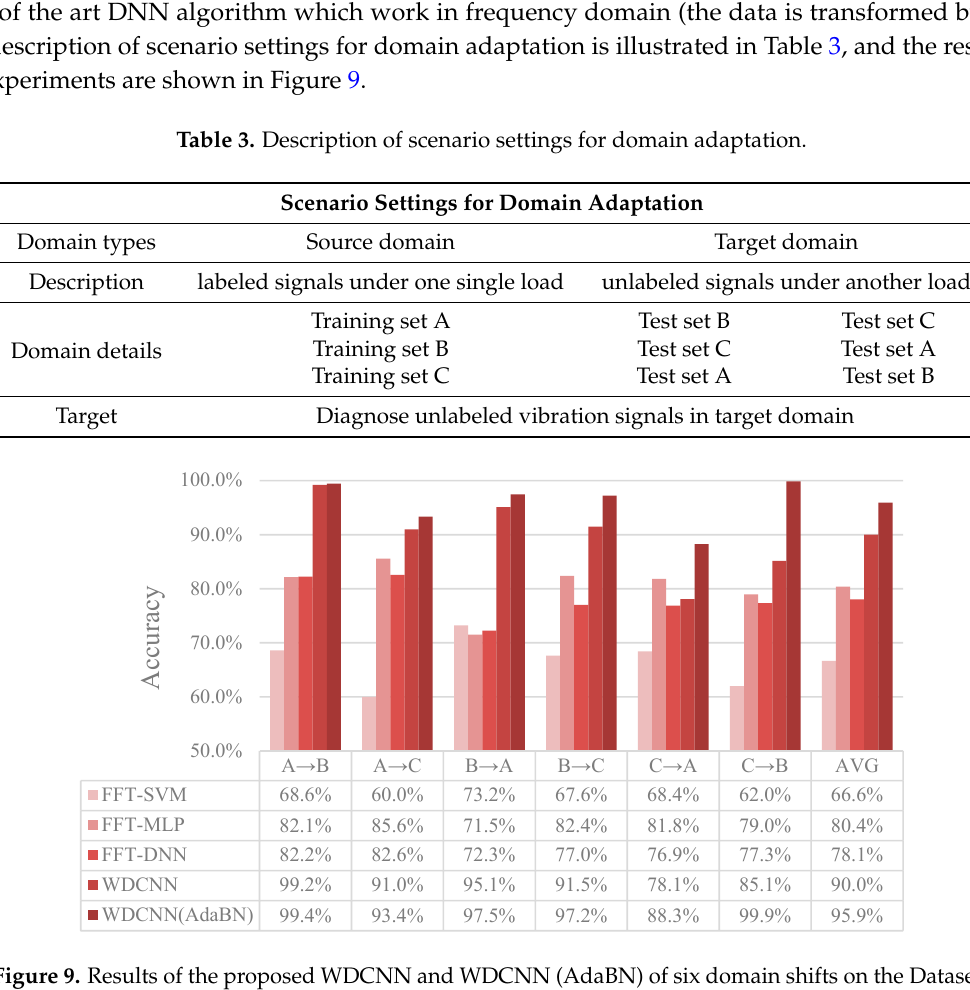
Figure 9. Results of the proposed WDCNN and WDCNN (AdaBN) of six domain shifts on the Datasets A, B and C, compared with FFT-SVM, FFT-MLP and FFT-DNN.